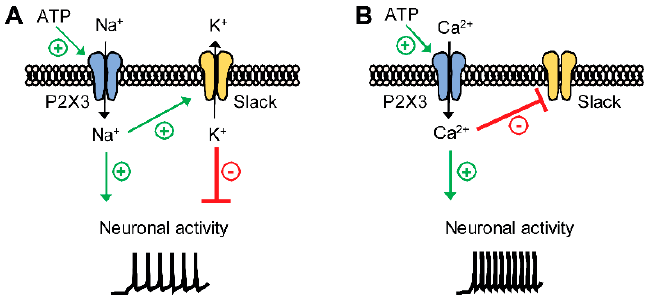
Figure 8. Proposed model demonstrating the functional coupling of Slack channels and P2X3 receptors in IB4-positive sensory neurons. Activation of P2X3 receptors by ATP may lead to an influx of Na + , Ca 2+ , or both into sensory neurons. ( A ) P2X3-mediated Na + influx activates Slack, which results in K + efflux and thus partial inhibition of neuronal activity. ( B ) P2X3-mediated Ca 2+ influx inhibits Slack, which leads to increased neuronal activity due to the lack of inhibition.